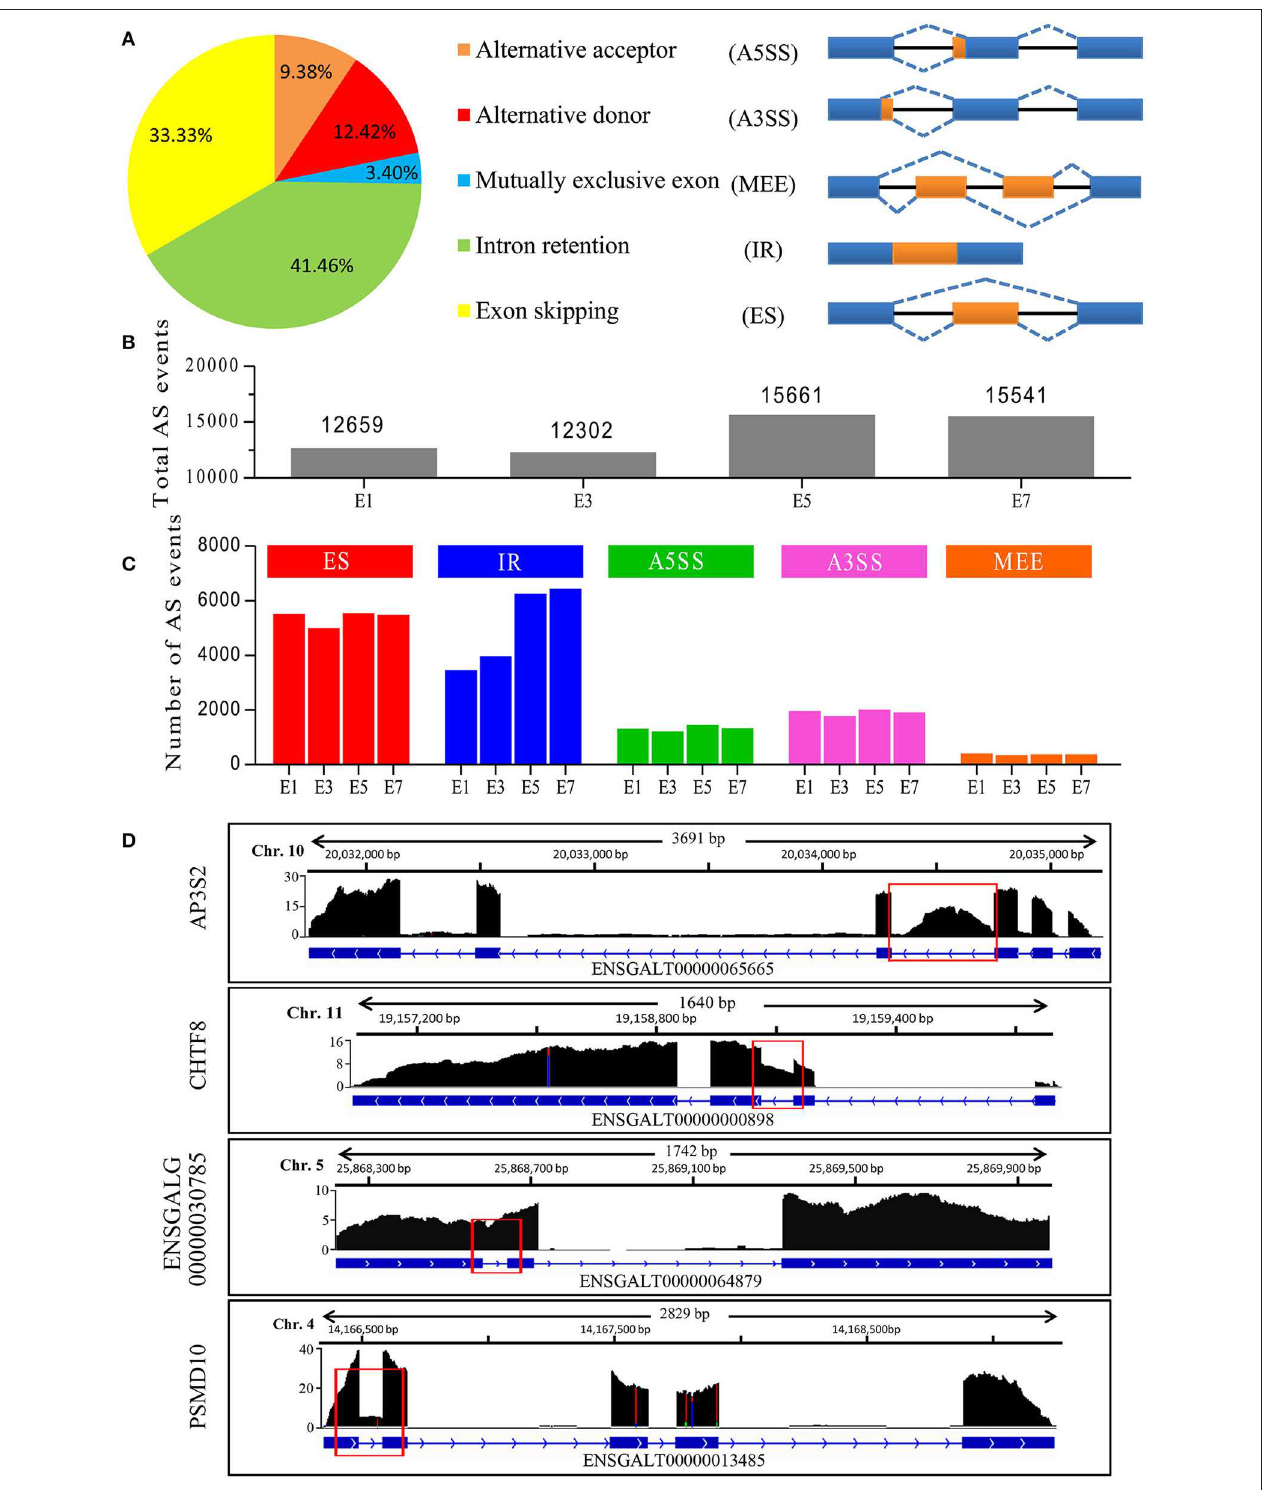
FIGURE 2 | Characterization of AS events in chicken embryos identified by Iso-Seq. (A) Distribution of different types of AS events generated by all PacBio transcripts and a schematic illustrating the five AS modes. (B) Total AS events identified at different stages of chicken embryo development. (C) Number of different AS events at the different stages of embryo development. (D) Wiggle plots showing RNA-seq reads mapped to genes with significant IR events. Y-axis represented the normalization value (Reads per 10 million). The representative retained introns are marked with red rectangles.